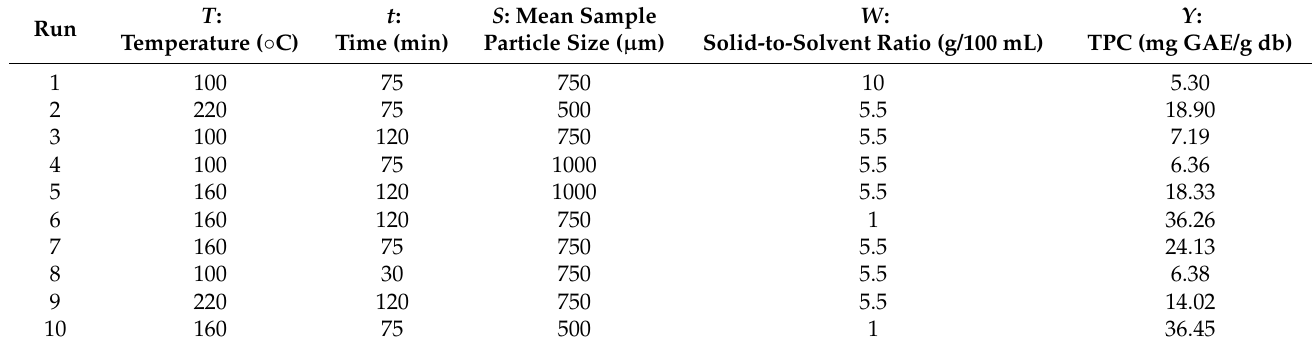
Table 3. The Box–Behnken design (BBD) matrix with experimental response data of TPC content at different process variable conditions was obtained through the SCW of apple pomace (fraction